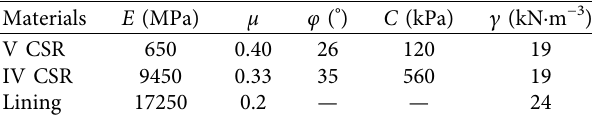
Table 3: Rock and lining material parameters.